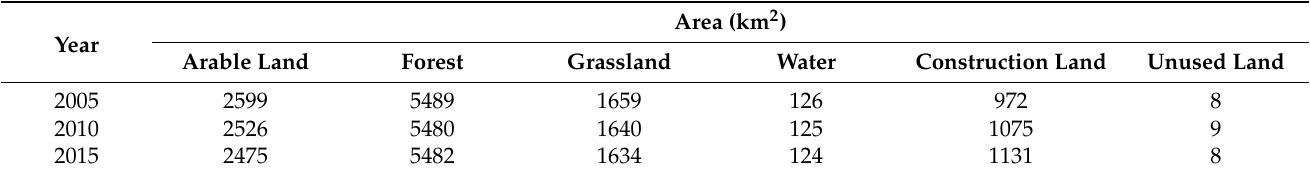
Table 4. Land use changes in Quanzhou during 2005–2015.